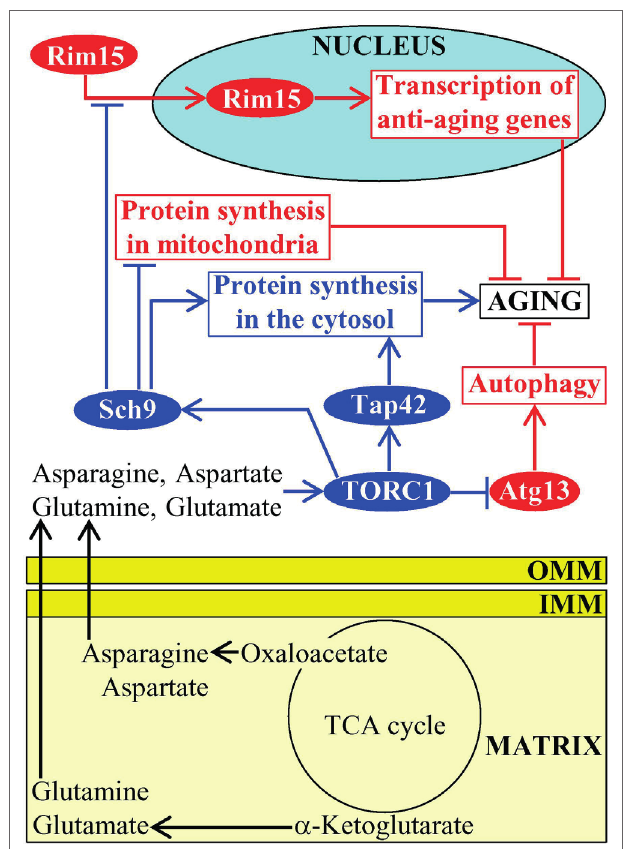
FIGURE 5 | Amino acids synthesized in mitochondria accelerate aging by stimulating TOR signaling. After being synthesized in mitochondria and then exported to the cytosol, the amino acids aspartate, asparagine, glutamate, and glutamine stimulate protein kinase activity of TORC1 on the surface of vacuoles. Once activated, TORC1 initiates a development of an aging- accelerating cellular pattern by phosphorylating and altering activities of Sch9, Tap42, and Atg13. Activation arrows and inhibition bars denote pro-aging (displayed in blue color) or anti-aging processes (displayed in red color). Pro-aging or anti-aging proteins are displayed in blue or red color, respectively. See the text for additional details. Abbreviations: Atg13, autophagy-related protein 13; IMM, inner mitochondrial membrane; TORC1, target of rapamycin complex 1; OMM, outer mitochondrial membrane; Rim15, regulator of IME2 protein 15; Sch9, serine/threonine-protein kinase 9; Tap42, two A phosphatase associated protein